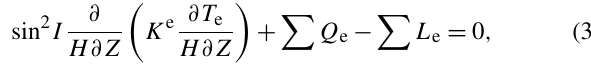
resolutions. The third column in Table 2 represents the num- ber of averaging chunks in each azimuthal ring near the pole from the first innermost to the outermost rings. For example, in the first azimuthal ring near the pole of the 0 . 625 ◦ × 0 . 625 ◦ grid resolution, 64 longitude grids (576 / 9 = 64) and 40 lon- gitude degrees (360 ◦ / 9 = 40 ◦ ) are grouped into a chunk. In the outermost filtered ring (around 71.25 ◦ latitude), one aver- aging chunk only contains two longitude grids. Table 3 sum- marizes the information on different spatial resolutions of the TIEGCM, including the current version of the 2 . 5 ◦ × 2 . 5 ◦ TIEGCM with the default FFT filter and the 2 . 5 ◦ × 2 . 5 ◦